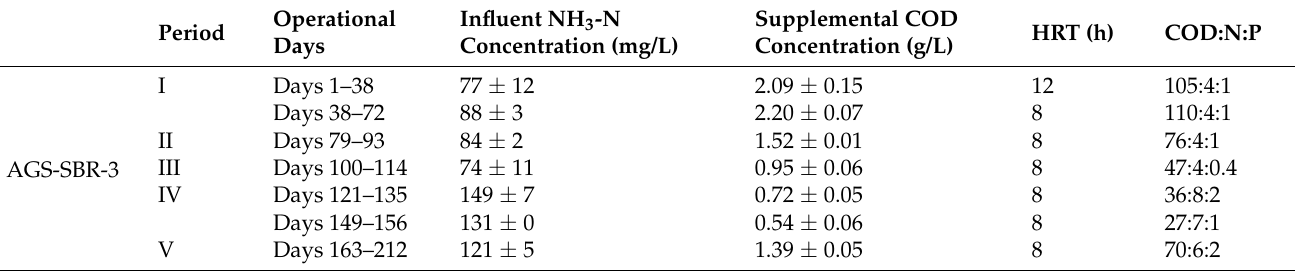
Table 4. Summary of reactor operational parameters for